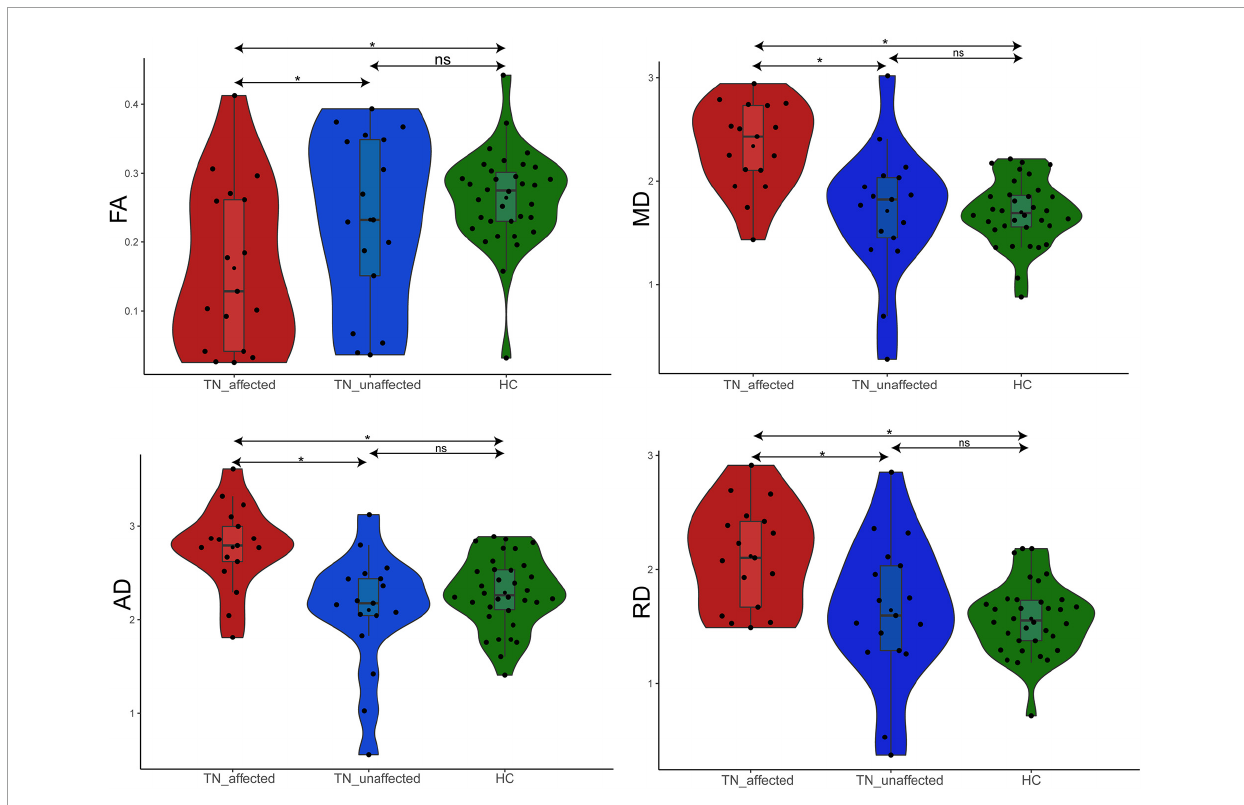
FIGURE2 Difference analysis of FA, MD, AD, and RD values in REZ among TN_affected side, TN_unaffected side, and HC groups. * p < 0.05.